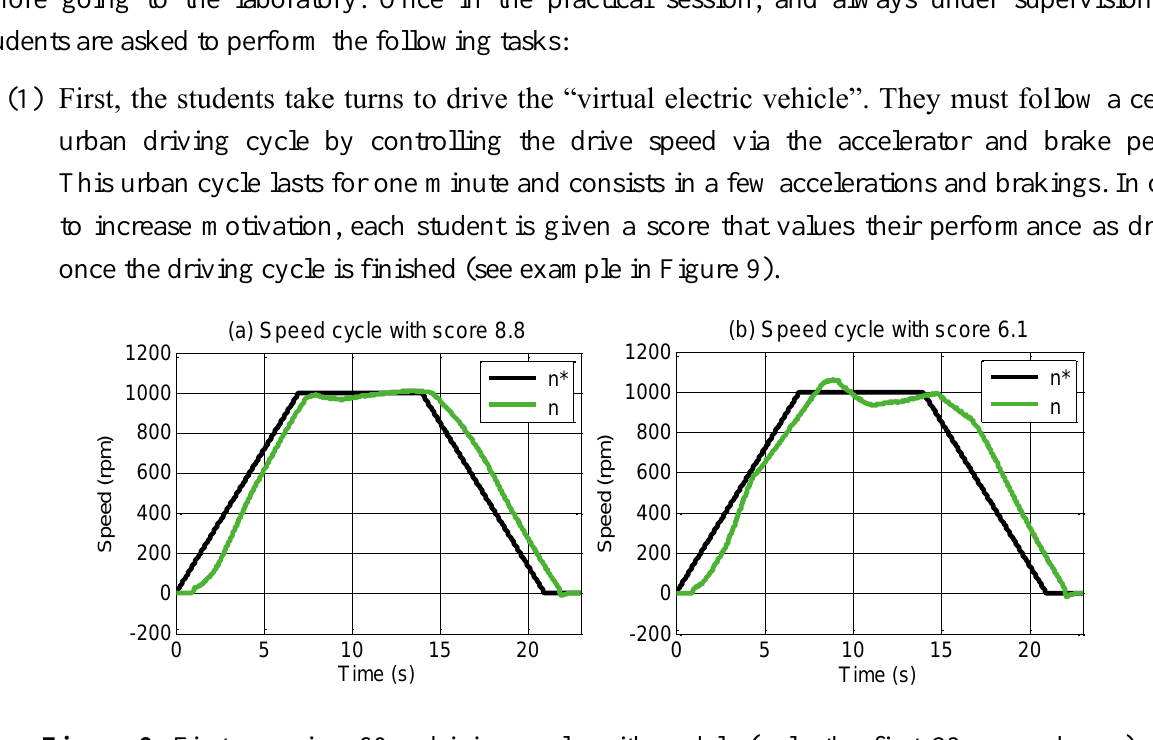
Figure 9. First exercise: 60-s driving cycle with pedals (only the first 23 s are shown). ( a ) Good driver (score: 8.8/10); ( b ) Not so good a driver (score: